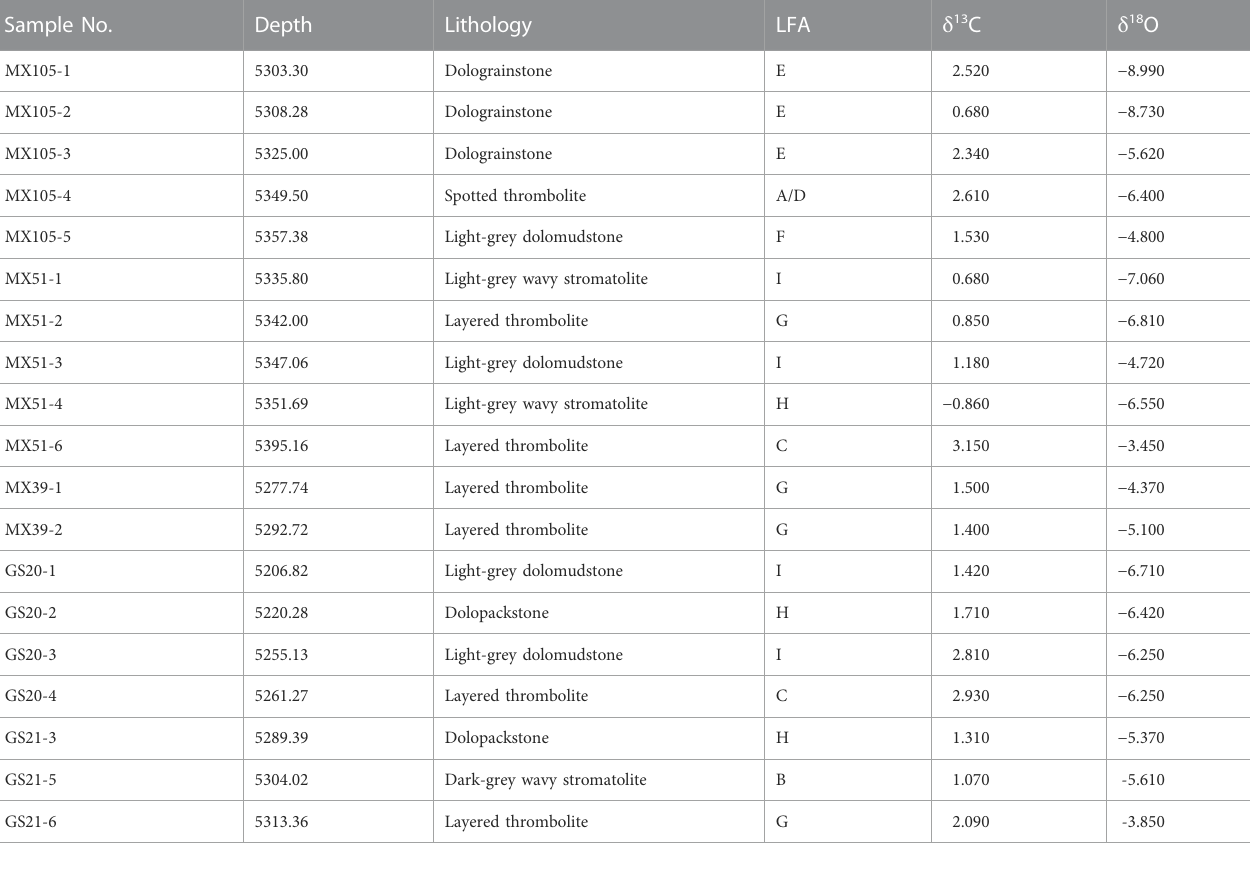
TABLE 3 δ 13 C and δ 18 O values of the studied samples with Mn/Sr ratios < 10 (LFA, lithofacies association). Sample No.